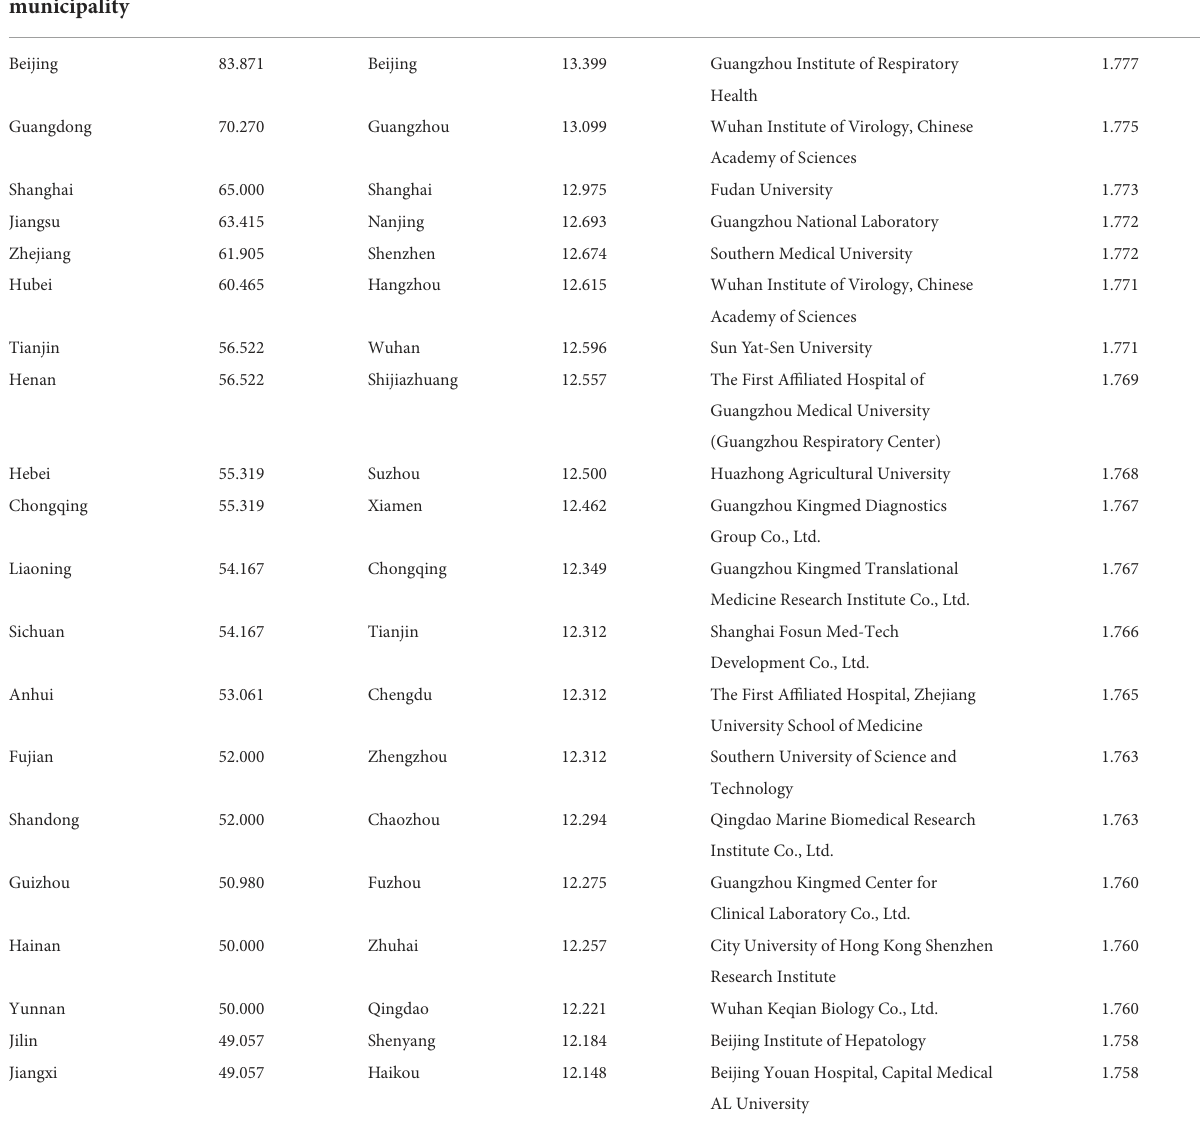
City Closeness centrality